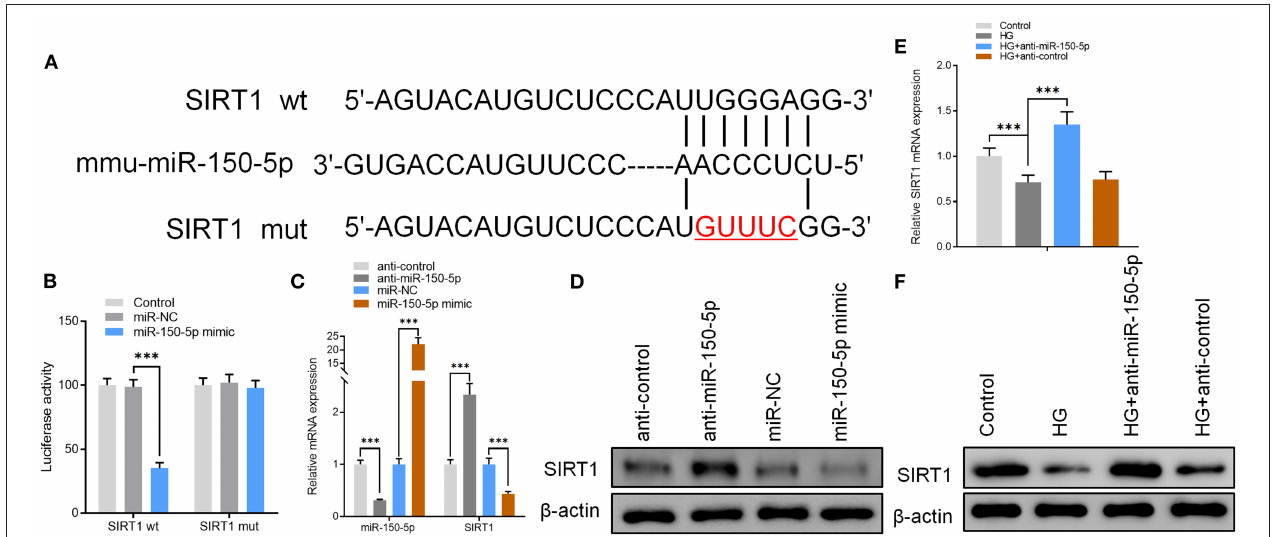
FIGURE 3 | miR-150-5p bound directly to the 3 ′ untranslated region (UTR) of sirtuin 1 (SIRT1) and suppressed SIRT1 expression. (A) The predicted binding sites of miR-150-5p in the 3 ′ UTR of SIRT1. The mutated version of the SIRT1 3 ′ UTR is also shown. (B) The relative luciferase activity was determined in podocytes 48h after transfection with the miR-150-5p mimic/control or the 3 ′ UTR of SIRT1 wt/mut constructs. (C) The levels of miR-150-5p and SIRT1 in podocytes were determined using qRT-PCR after transfection with anti-miR-150-5p or miR-150-5p mimic for 48h. (D) The protein levels of SIRT1 in podocytes were determined using Western blot after transfection with anti-miR-150-5p or miR-150-5p mimic for 48h. (E) The levels of SIRT1 in podocytes were determined using qRT-PCR and Western blot after transfection with anti-miR-150-5p and culture in high glucose for 48h. (F) The protein levels of miR-150-5p and SIRT1 in podocytes were determined using Western blot after transfection with anti-miR-150-5p and culture in high glucose for 48h. Data are expressed as mean ± SEM ( n = 3; ** p < 0.01, *** p < 0.001).